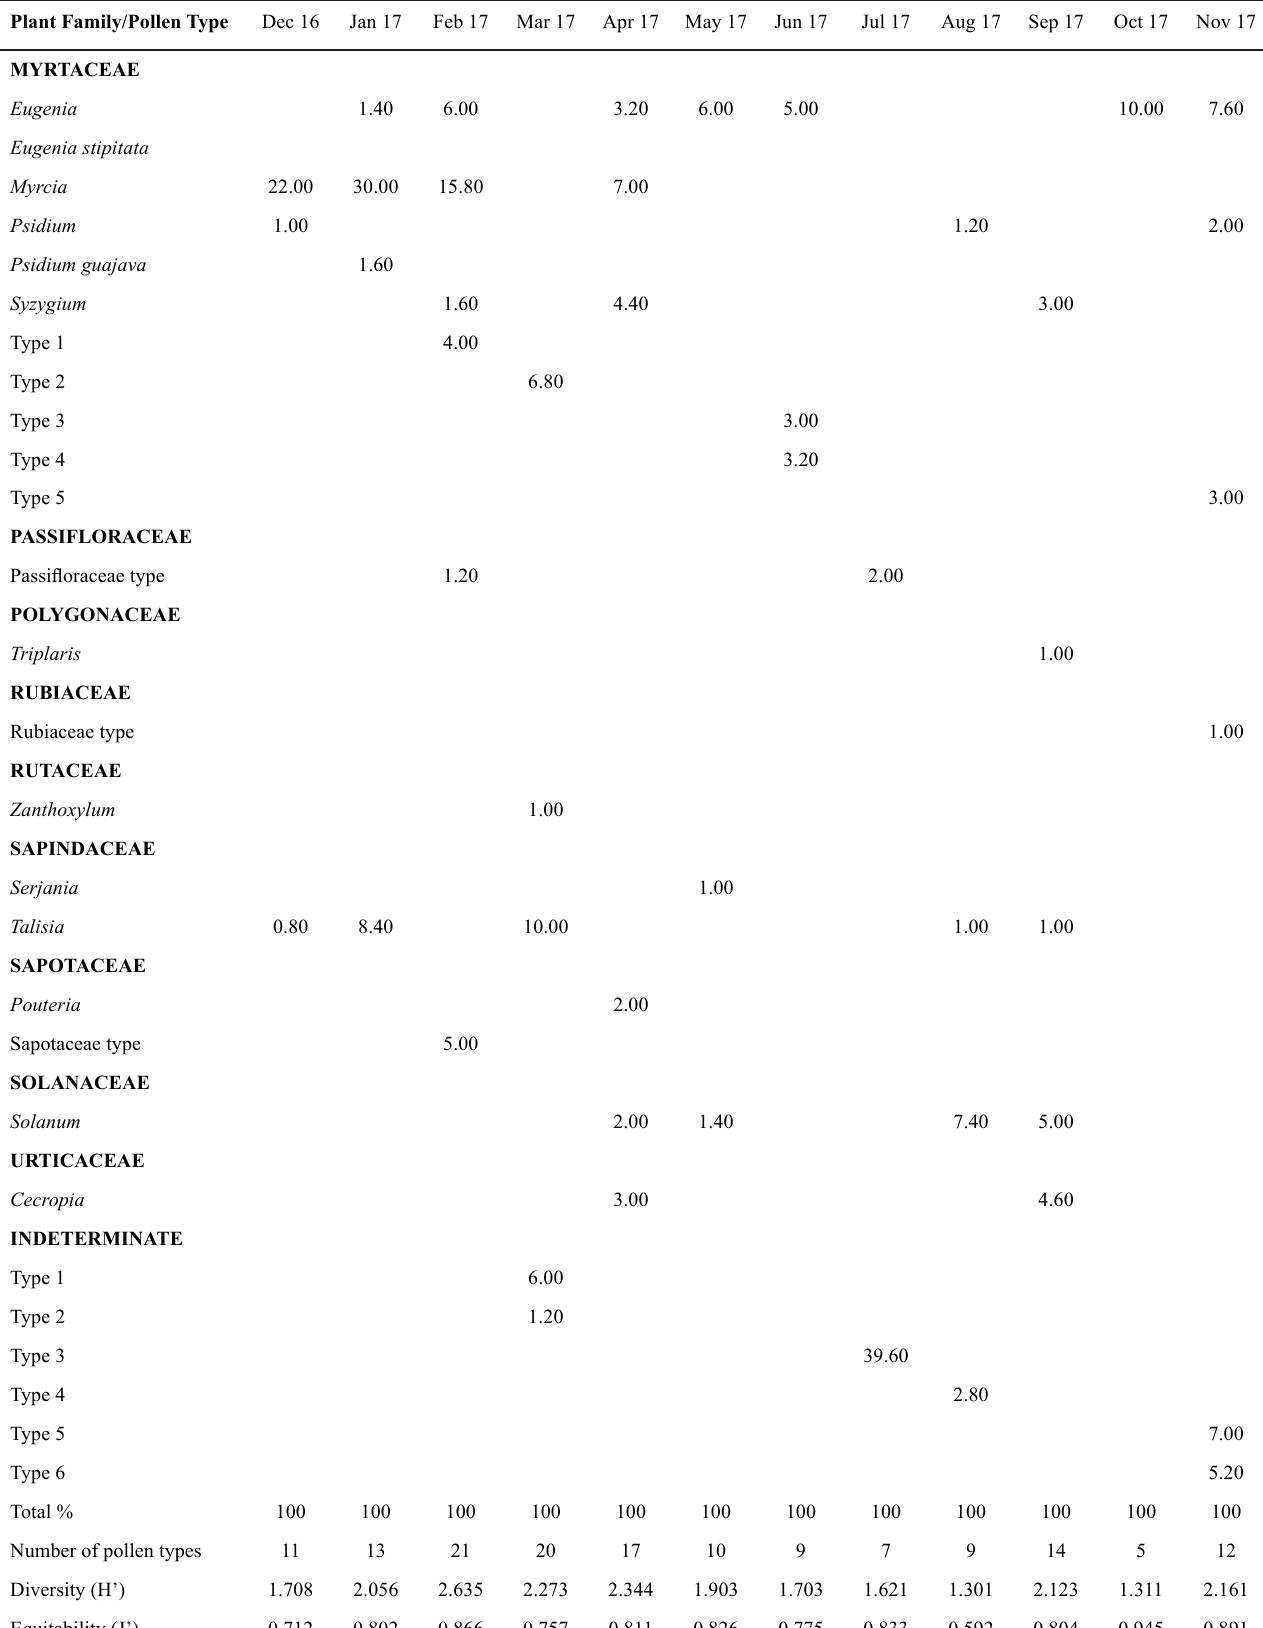
Table 1 . Frequency of pollen types found in honey samples of Melipona seminigra pernigra (Apidae: Meliponini) collected from December 2016 (Dec 16) to November 2017 (Nov 17) in the community of Suruacá, Tapajós-Arapiuns Extractive Reserve, Santarém (PA), Brazil.